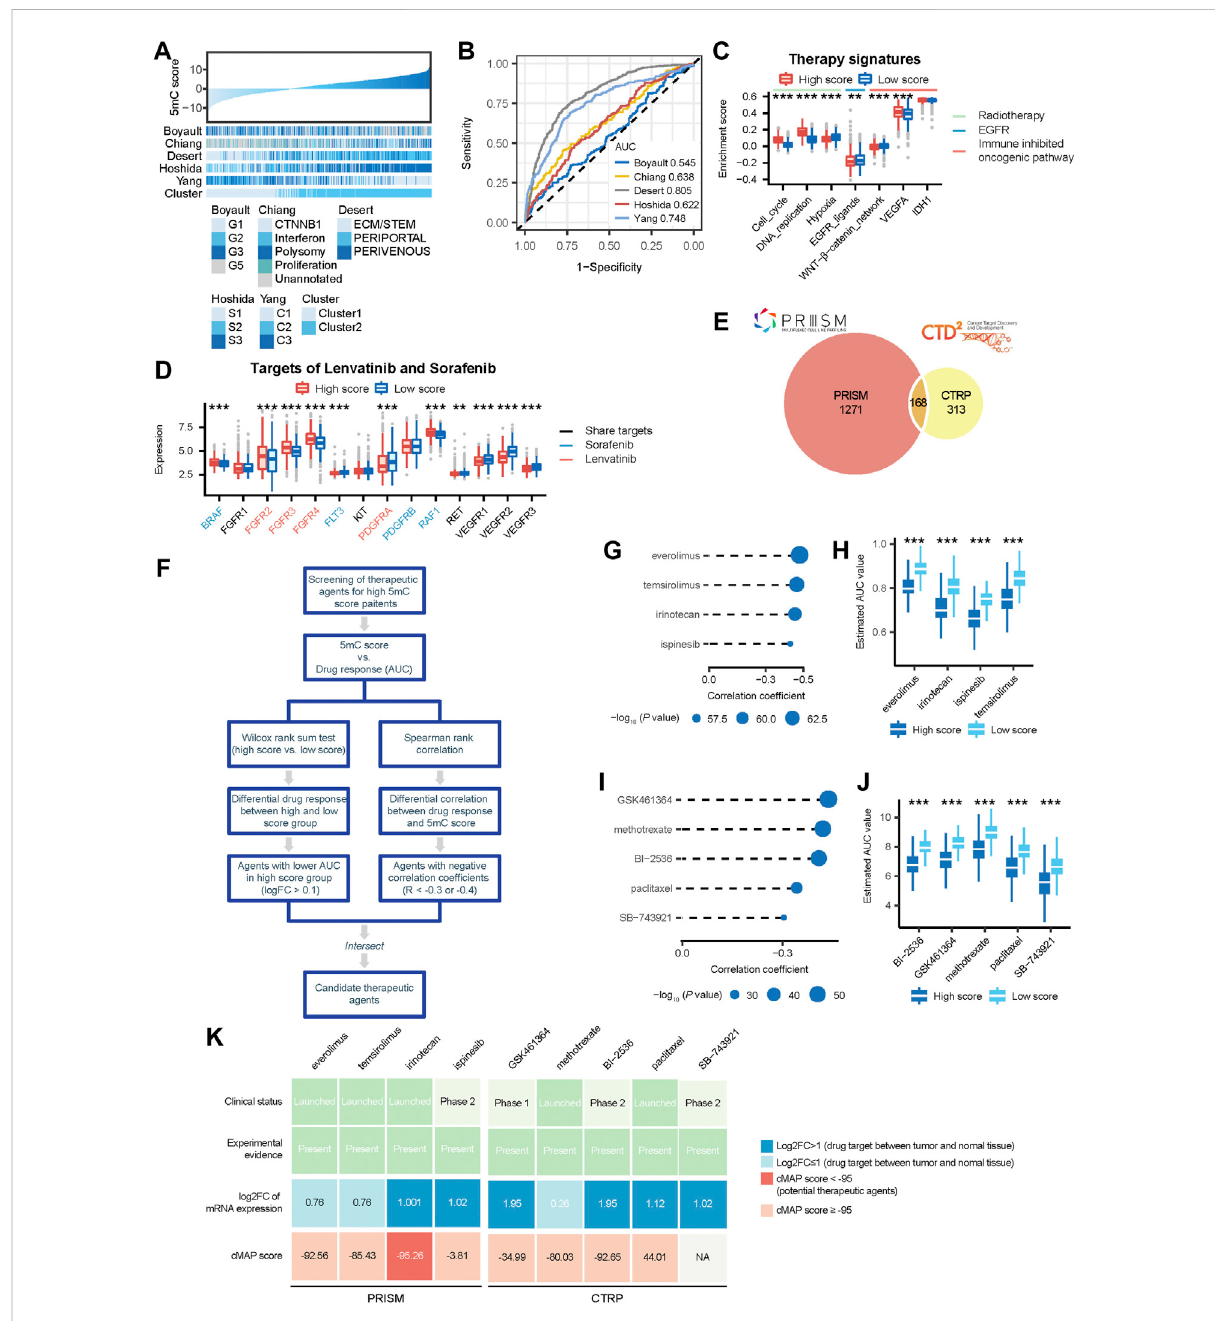
FIGURE 5 5mC scores accurately predicted classical molecular subtypes and therapeutic opportunities in the meta cohort. (A) The association between 5 mC scores and classic molecular subtypes. (B) ROC curves showed the accuracy of the 5 mC score in predicting classic molecular subtypes. (C) Difference in the enrichment scores of several therapeutic signatures, such as targeted therapy and radiotherapy, between the high and low score groups. (D) Comparisonoftheleveloflenvatinibandsorafenibtargetexpressionbetweenthehighandlowscoregroups. (E) AVenndiagramof compounds from the CTRP and PRISM datasets. (F) The work fl ow of identifying potential therapeutic agents. (G) Spearman correlation between 5 mC scores and drug response predicted by PRISM datasets. The point size was negatively correlated with the p value. (H) Comparison of drug response predicted by PRISM datasets between the high and low score groups. (I) Spearman correlation between 5 mC scores and drug response predicted by CTRP datasets. Point size was negatively correlated with the p value. (J) Comparison of drug response predicted by CTRP datasets between the high and low score groups. (K) Identi fi cation of most promising therapeutic agents for patients with high PPS scores according to the evidence from multiple sources. * p < 0.05, ** p < 0.01, *** p <